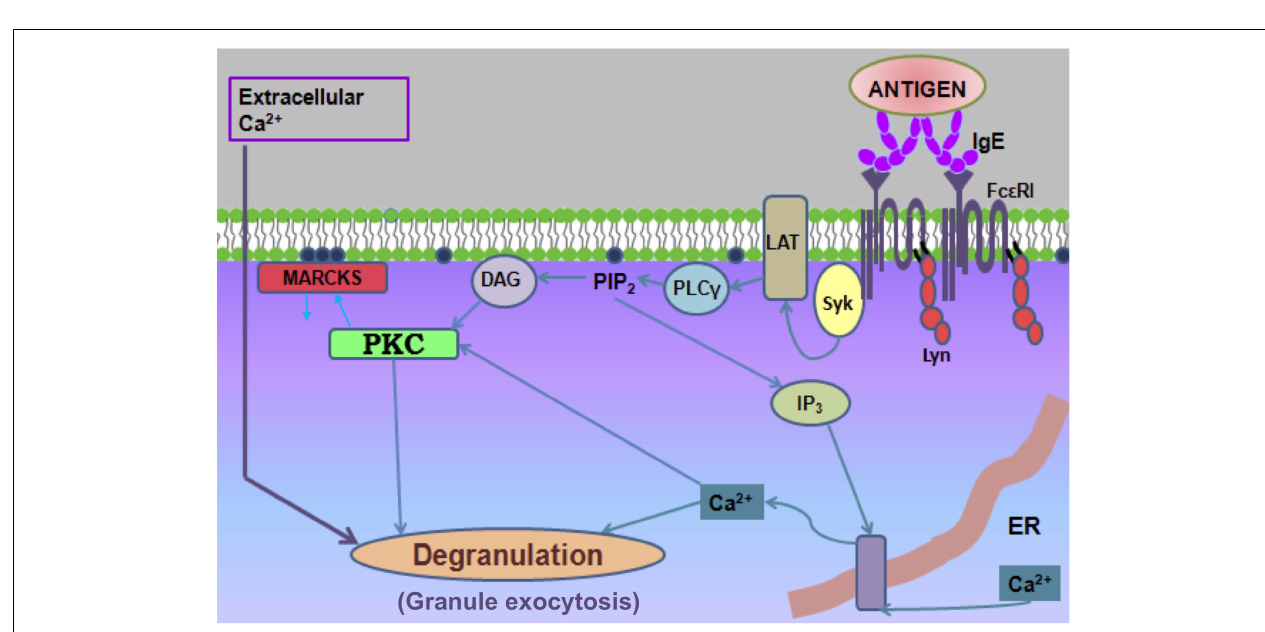
FIGURE 4 | Cartoon depicting key steps in Fc ε RI signaling leading to degranulation, including PKC-dependent dissociation of the MARCKS protein from the plasma membrane. Crosslinking of IgE–Fc ε RI complexes by antigen results in receptor phosphorylation by Lyn, recruitment and